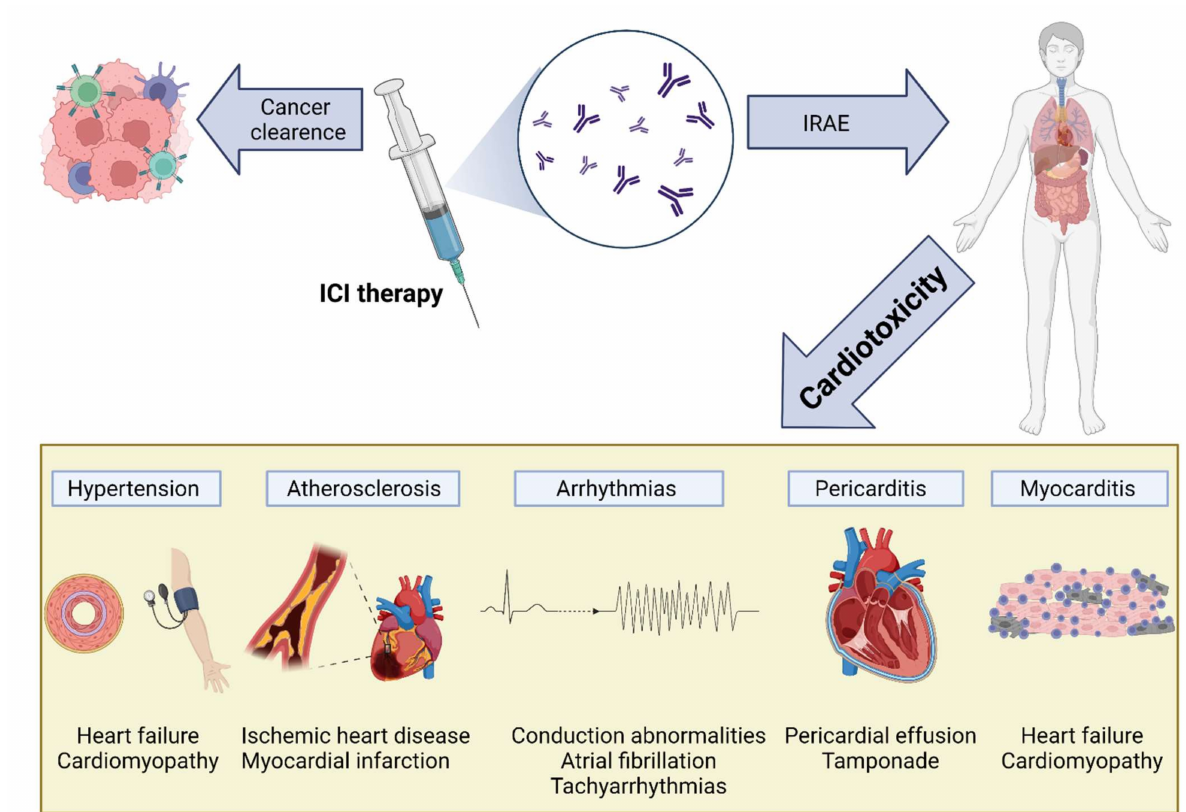
Figure 4. Cardiovascular toxicity induced by immune checkpoint inhibitor (ICI) therapy. The reactivation of T cells in response to ICIs is mediated by inflammation and fibrosis, leading to various cardiac manifestations, including myocarditis, pericarditis and pericardial effusion, ar- rhythmias, atherosclerosis, and hypertension: IRAEs, immune-related adverse events; ICI, immune checkpoint